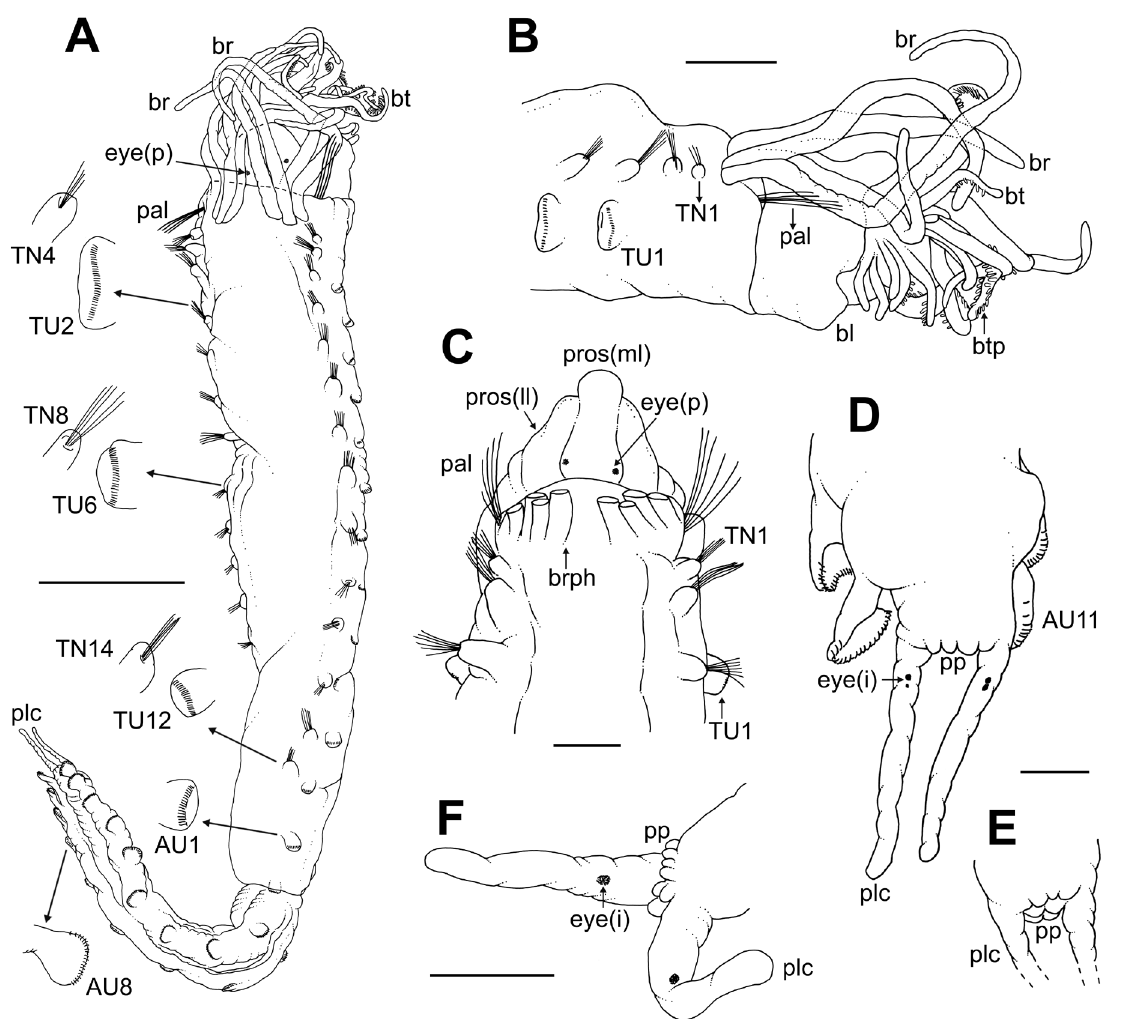
Fig. 1. Ampharete oculicirrata sp. nov., holotype NMS.Z.2019.8.1 (A–B, D–E), paratype MNCN 16.01/18476 (C, F). A . Complete specimen, dorsolateral view, and detail of several thoracic and abdominal parapodia. B . Anterior end, lateral view. C . Anterior end, dorsal view. D – E . Posterior end, dorsal and ventral view. F . Posterior end, lateral view. Abbreviations: AU = abdominal unciniger; bl = buccal lip; br = branchia; brph = branchiophore; bt = buccal tentacle; btp = buccal tentacle pinna; eye(i) = pygidial eye; eye(p) = prostomial eye; pal = paleae; plc = pygidial lateral cirrus; pp = pygidial papillae; pros(ll) = prostomium (lateral lobe); pros(ml) = prostomium (median lobe); TN = thoracic notopodium; TU = thoracic unciniger. Scale bars: A = 1 mm; B–C = 200 µm; D–F = 100